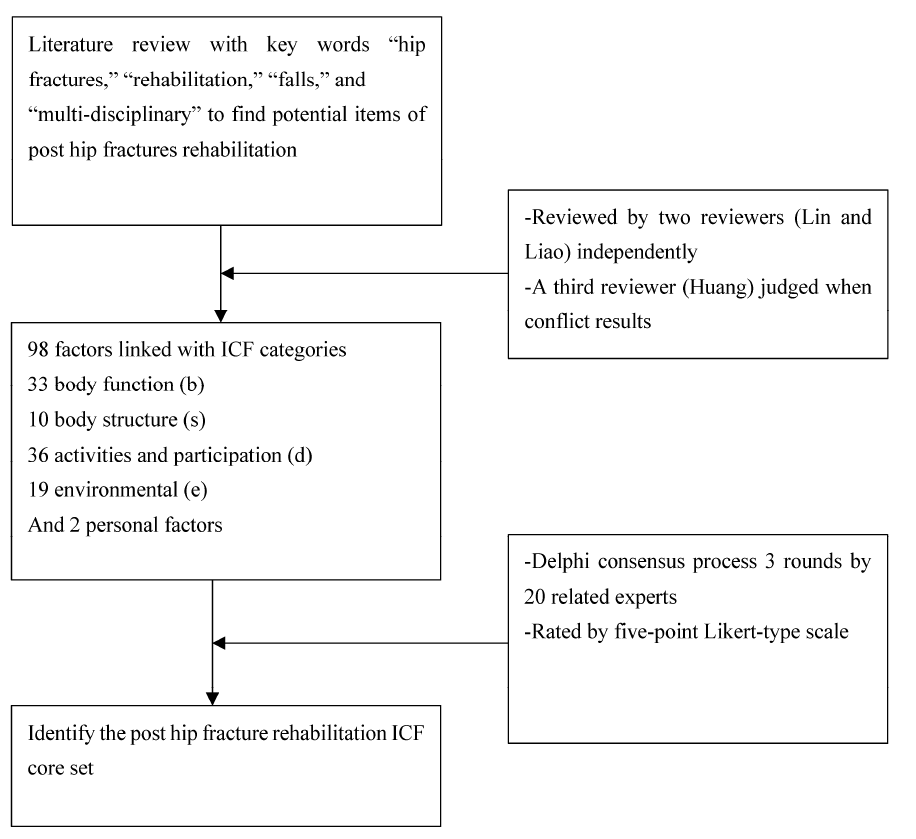
Figure 1. Study flowchart.